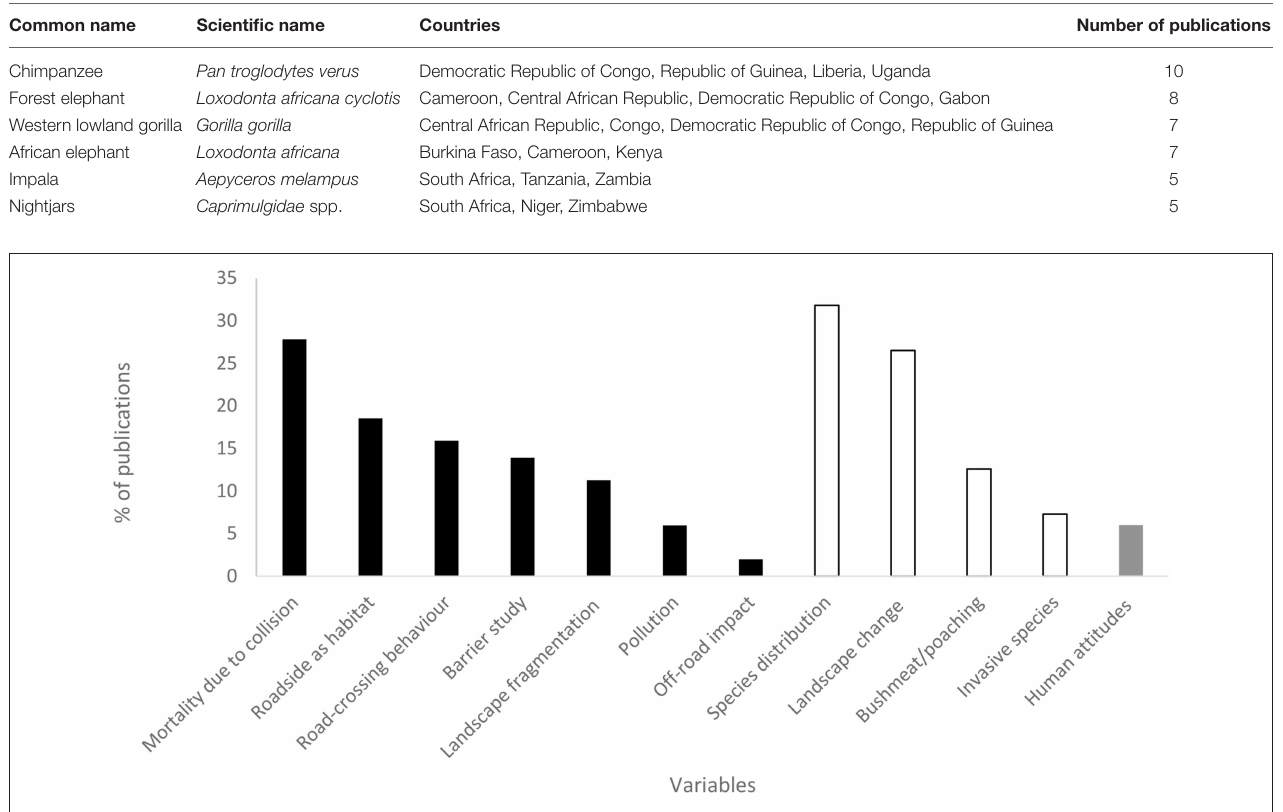
FIGURE 7 | The percentage of publications assessing different impacts of linear infrastructure (black columns represent direct impacts, white columns represent indirect impacts and grey columns represent human